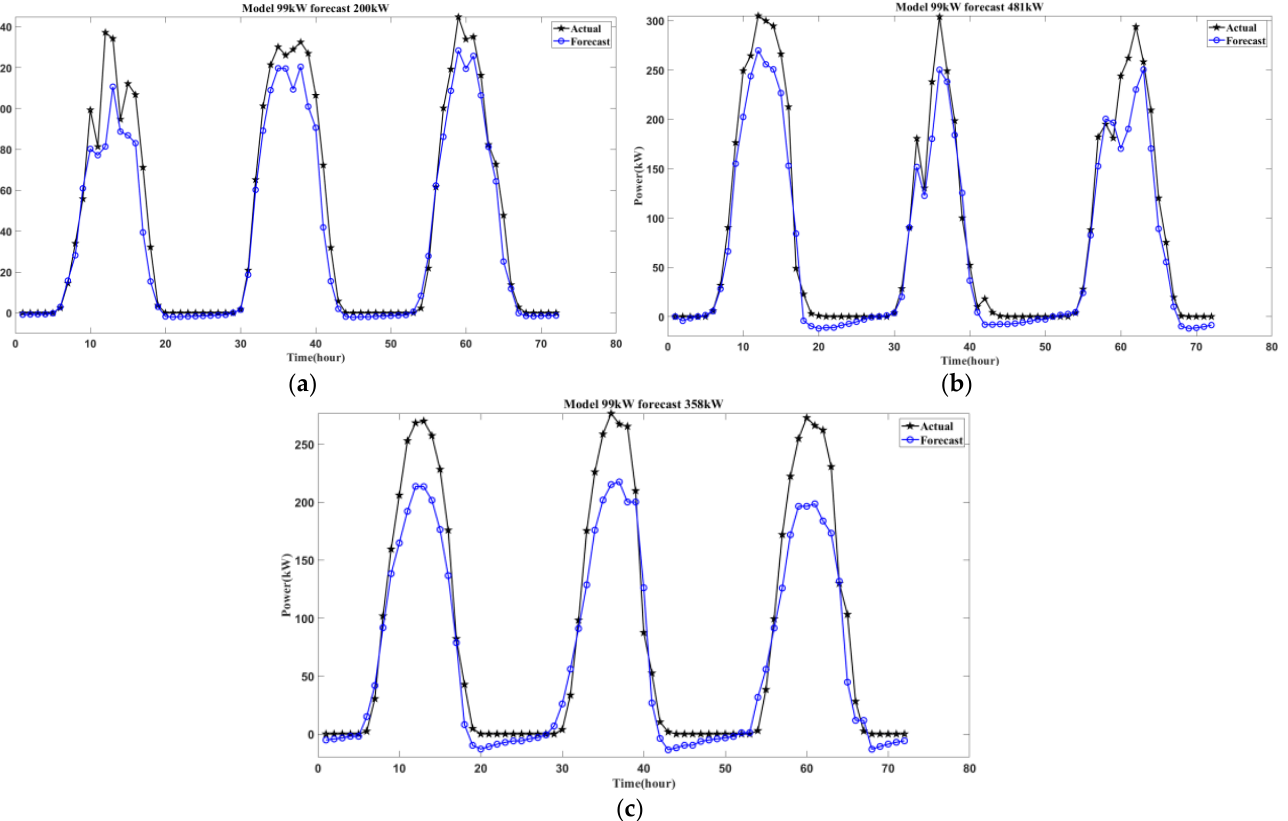
Figure 13. Model universality verification via training data of solar power plant C: ( a ) testing data via solar power plant B; ( b ) testing data via solar power plant D; ( c ) testing data via solar power plant E.